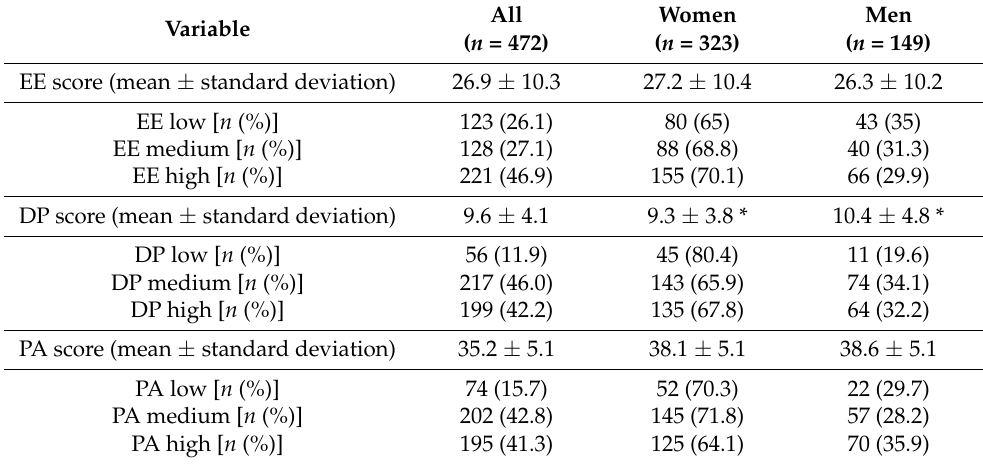
Table 2. Scores and levels of the Maslach Burnout Inventory—Human Services